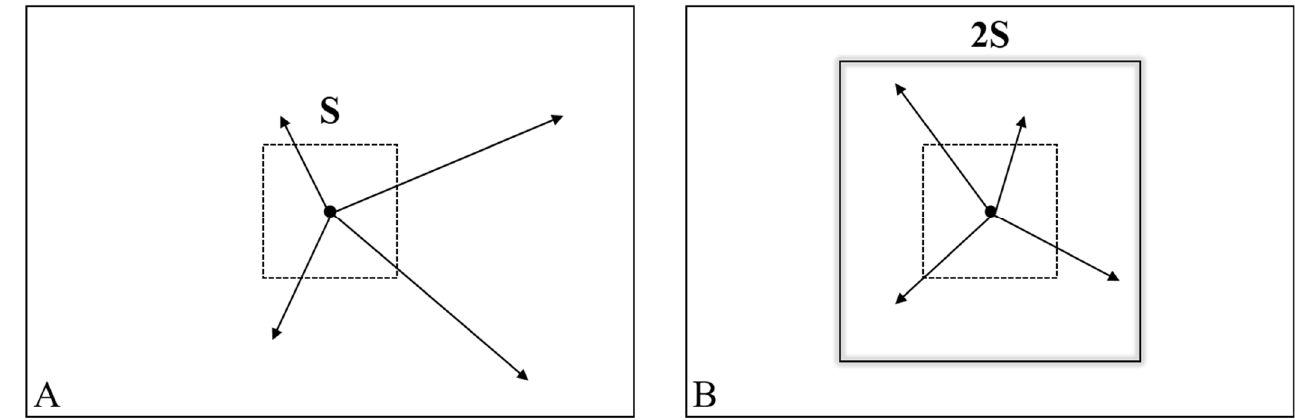
Figure 5. Superpixel reduction search region. ( A ) The standard k-means search region; ( B ) SLIC model search